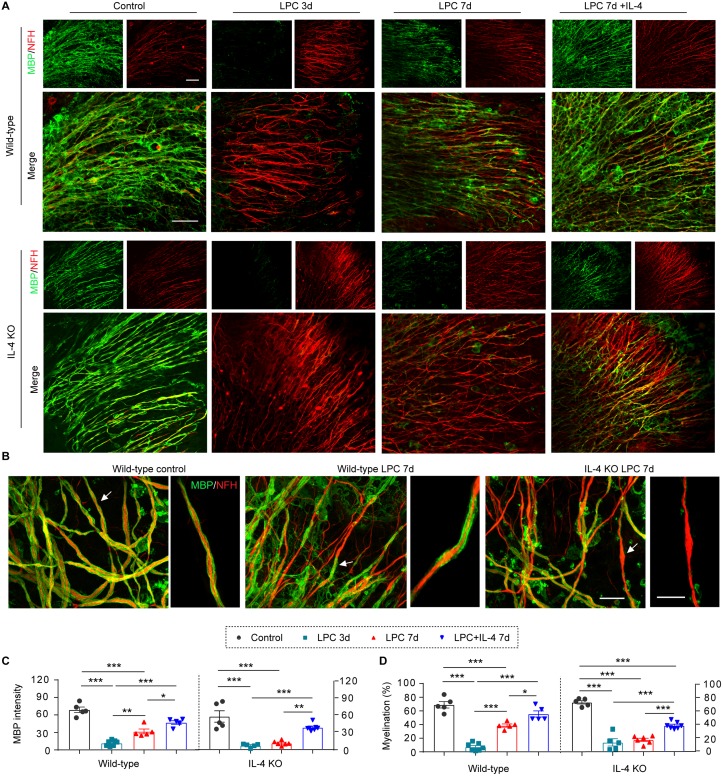
IL-4 promotes remyelination after LPC-induced demyelination in organotypic cultures.LPC (500 μg/mL) was added in WT or IL-4 KO organotypic cultures for 17 h to induce demyelination. IL-4 (20 ng/mL) or vehicle was added after LPC removal. Culture slices were fixed 3 d and 7 d after LPC treatment. Control cultures were maintained in normal culture media for 7 d. (A) MBP (green) and NFH (red) staining was performed to label myelin and axonal fibers, respectively. Scale bar: 50 μm. (B) MBP and NFH double staining and Imaris 3D reconstruction. Arrows indicate myelination of individual axonal fibers that are magnified in the images to the right. Scale bar: 15 μm. (C) Myelin integrity was measured as the intensity of MBP immunostaining. (D) The myelination index was calculated as the % MBP+ myelin coverage along the entire NFH+ fibers. n = 5–7 slices/group. *p < 0.05, **p < 0.01, ***p < 0.001. One-way ANOVA and Bonferroni post hoc. Data associated with this figure can be found in the supplemental data file (S1 Data). IL-4, interleukin-4; KO, knockout; LPC, lysophosphatidylcholine/lysolecithin; MBP, myelin basic protein; NFH, neurofilament heavy; WT, wild-type.